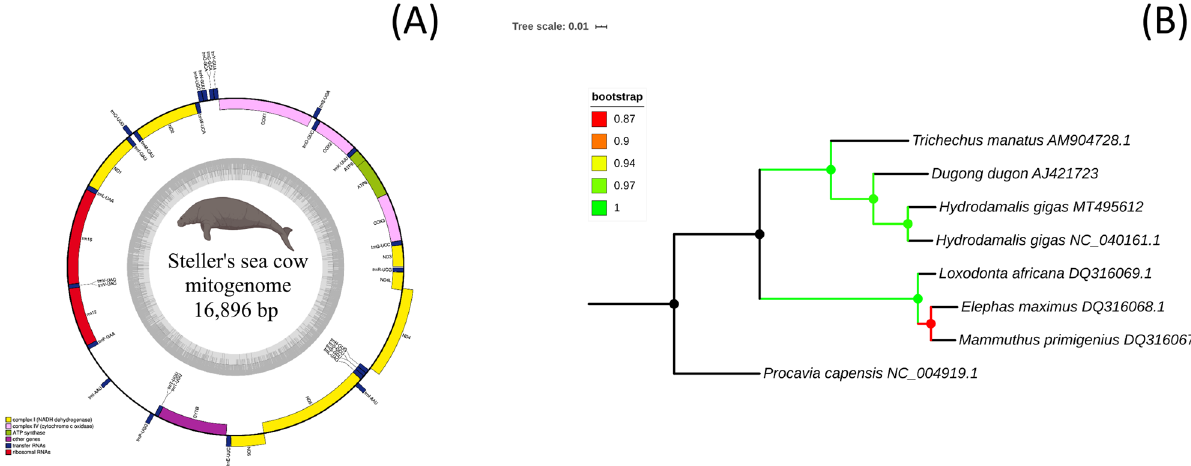
Fig. 3 The mitochondrial genome of Steller ’ s sea cow. A Graphical map of the complete mitochondrial genome of Steller ’ s sea cow with its gene features. Mitochondrial NADH dehydrogenase genes are marked by yellow color; mitochondrial cytochrome oxidase genes are marked by pink color; mitochondrial ribosomal RNA genes are marked by red color; mitochondrial ATP synthase genes are marked by green color; mitochondrial cytochrome B gene is marked by purple color; mitochondrial transfer RNA genes are marked by blue color. B Maximum likelihood phylogenetic tree reconstruction of Tethytheria species, including the extinct Steller ’ s sea cow, based on their coding sequences. Bootstrap values are shown by color (from lower values — red to higher values —